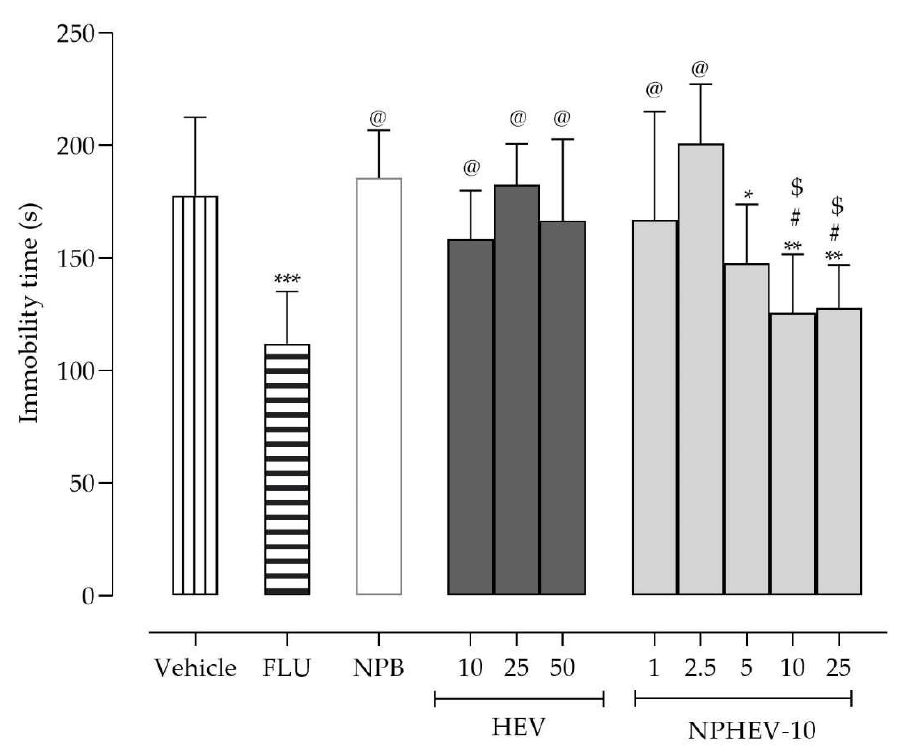
Figure 3. Dose–response curves of HEV (10, 25, and 50 mg/kg), NPHEV-10 (1, 2.5, 5, 10, and 25 mg/kg), NPB, and fluoxetine (FLU, 30 mg/kg) after single intragastric treatment in TST. Values are expressed as mean ± SEM. Asterisks denote the significant difference in comparison to the vehicle (* p < 0.05; ** p < 0.01; *** p < 0.001), sharps indicate the difference in comparison to NPB ( # p < 0.05), arroba denotes a significant statistical difference with fluoxetine group ( @ p < 0.05), and ciphers denote the significant difference between the same doses of HEV and NPHEV-10 ( $ p < 0.05). Data were tested using ordinary one-way ANOVA, followed by Newman-Keuls’ test.